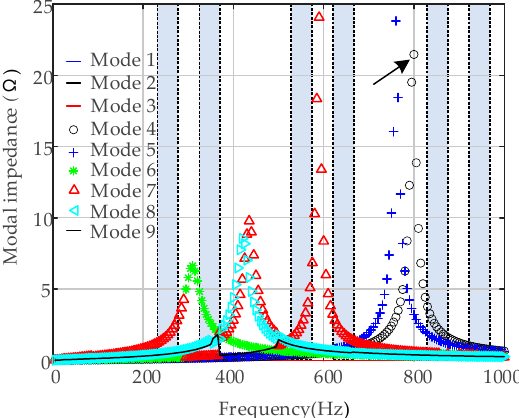
Figure 13. Modal impedances of the test system with three inverters on bus 4.